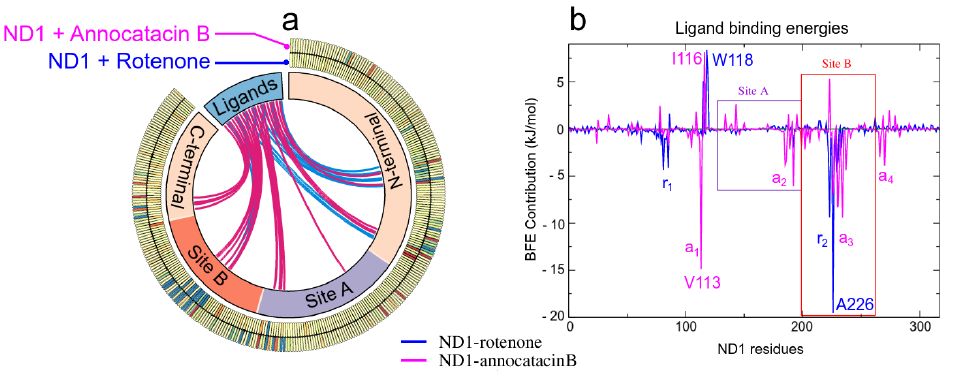
Figure 9. MM/PBSA analysis. ( a ) Circos plot representation of the ND1–ligand structures,where the interactions of the ND1 subunit residues to the ligand molecules are shown as links inthe middle of the plot. The blue lines indicate interactions with rotenone and the magenta lines, with annocatacin B. The outer part of this plot shows the heat map of the BFE per residue, where blue color represents favorable BFE, red color unfavorable BFE, and yellow color indicates neutral energies. ( b ) Energy per-residue contributions